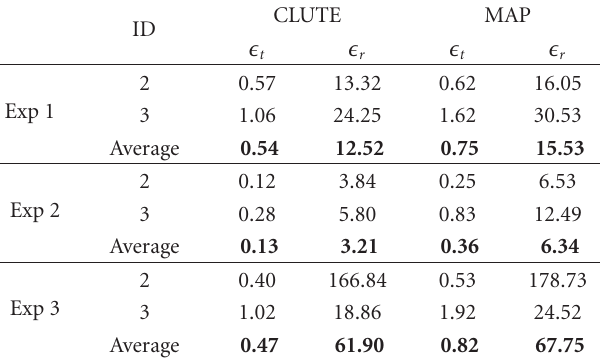
Table 4: 4-camera network: CLUTE and MAP comparison for 1- camera failure.